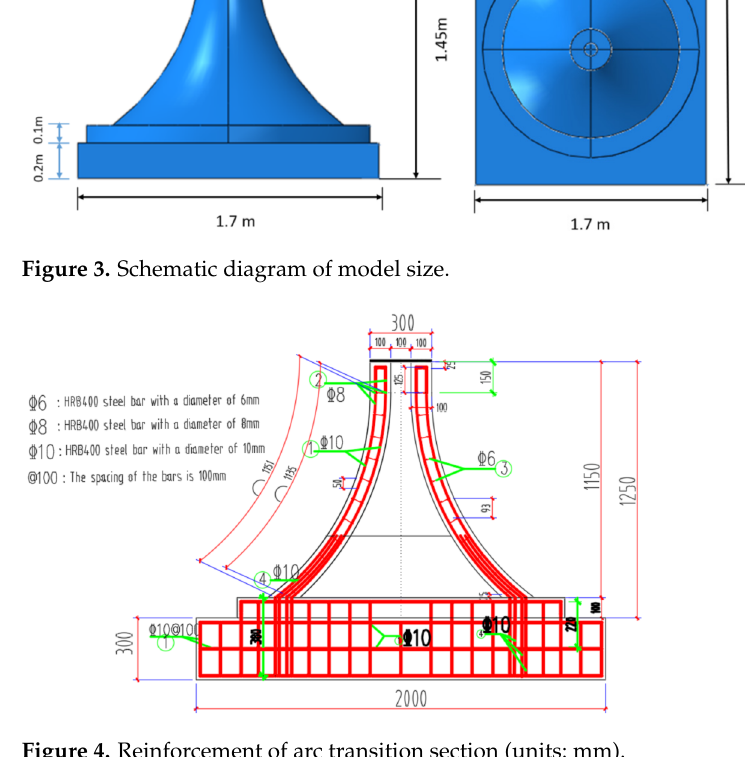
Figure 4. Reinforcement of arc transition section (units: mm).